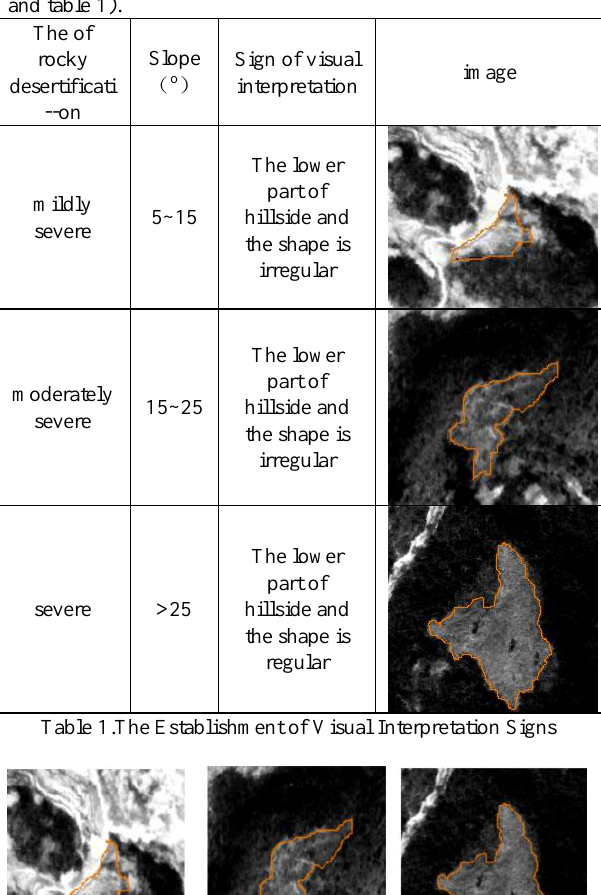
Figure 12.Rocky desertification area of Liupanshui in 1960s